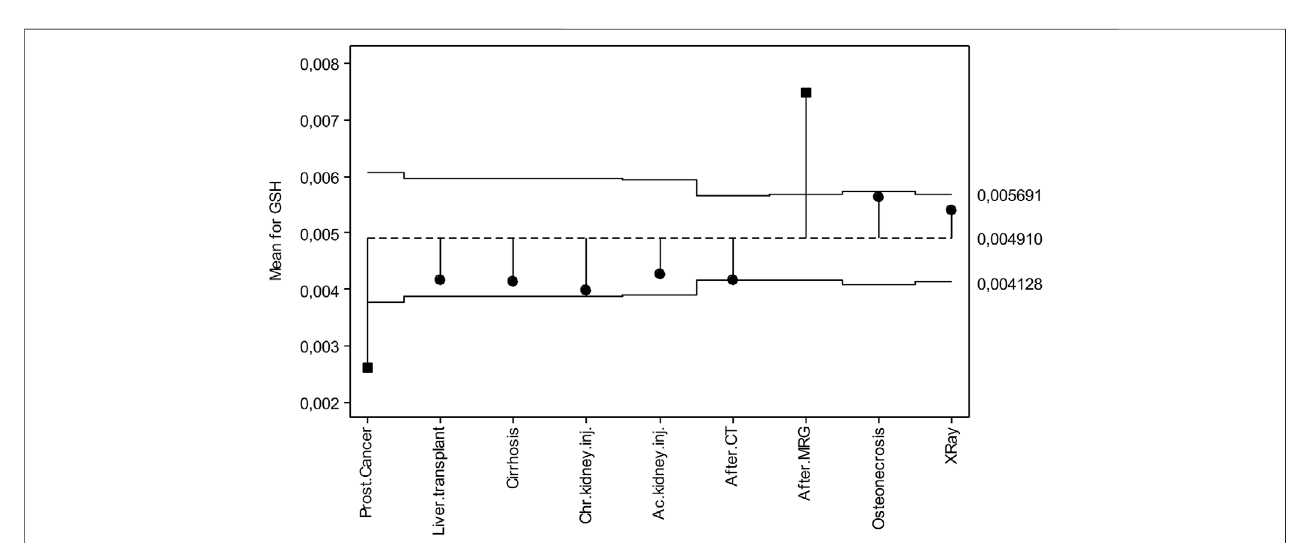
FIGURE 4 | ANOM diagram for GSH